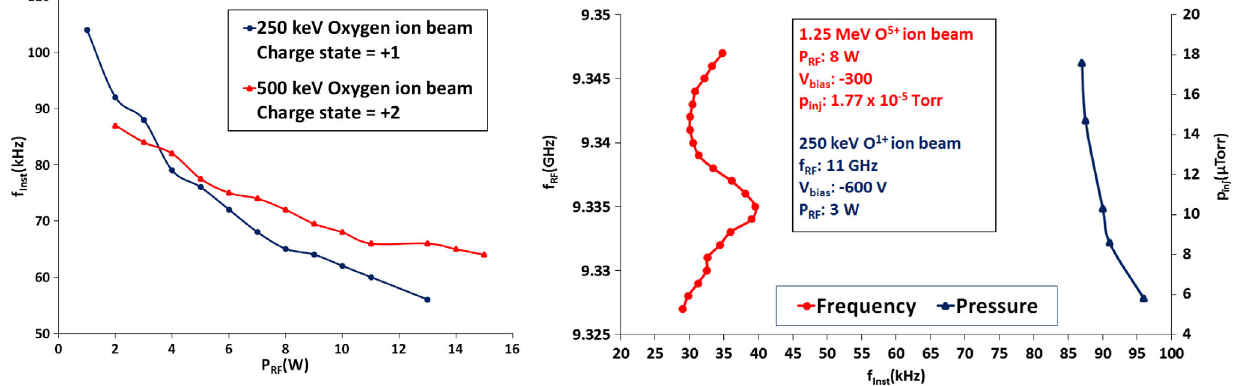
FIG. 5. Effect of (a) rf power and (b) radio frequency and injection pressure of gas on the tunability of plasma instability frequency.